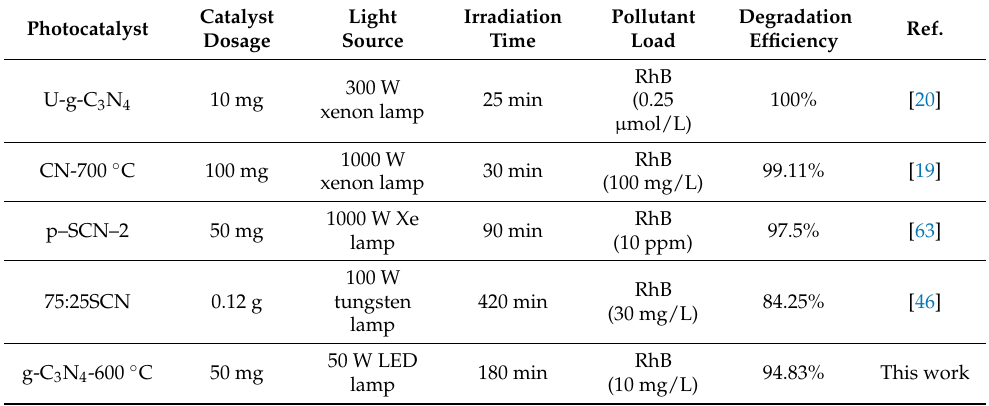
Table 3. Comparison of photocatalytic activities of some selected photocatalysts with the present